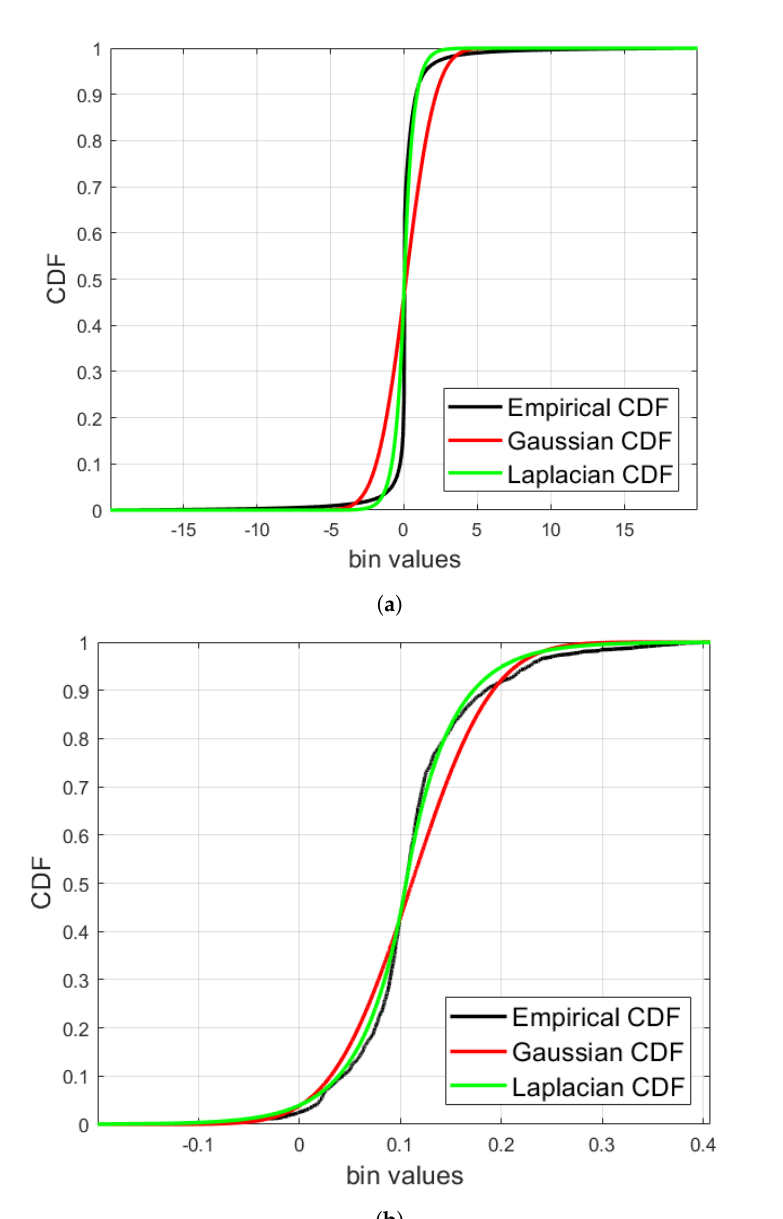
Figure 4. Cumulative distribution functions (CDFs) for ( a ) non - rain VDR data and ( b ) rain VDR data. The empirical CDFs are the estimated CDFs from the data, i.e., considering non - rain data in ( a ) and rain data in ( b